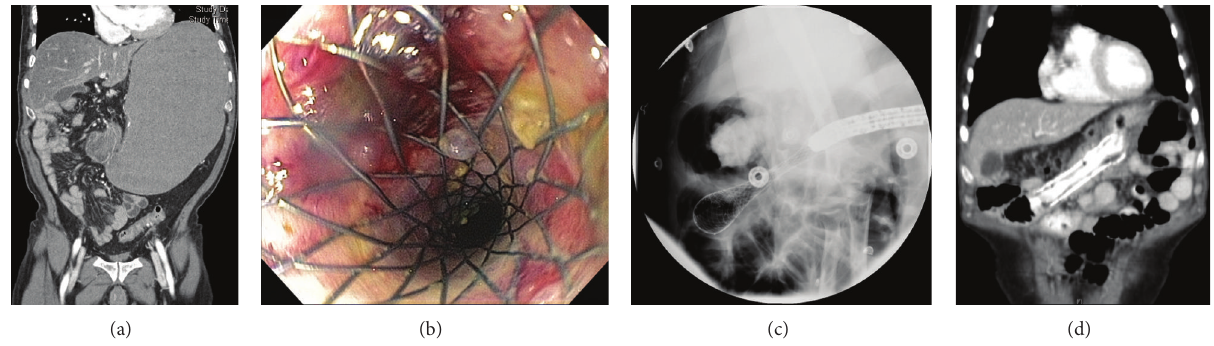
Figure 1: (a) Coronal CT image reveals a malignant gastric outlet obstruction at the gastrojejunal anastomosis. (b) The patient underwent endoscopic placement of a 90 mm × 22 mm WallFlex Enteral Stent across the malignant stricture. (c) Fluoroscopy immediately following stent placement confirms the enteral stent in place. (d) Coronary CT image obtained two months following stent placement confirms the enteral stent in place.